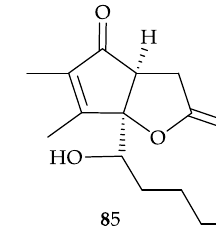
Figure 13. Structures of dendronephthyones A–C ( 83 – 85 ) and suberosanone B ( 86 ).